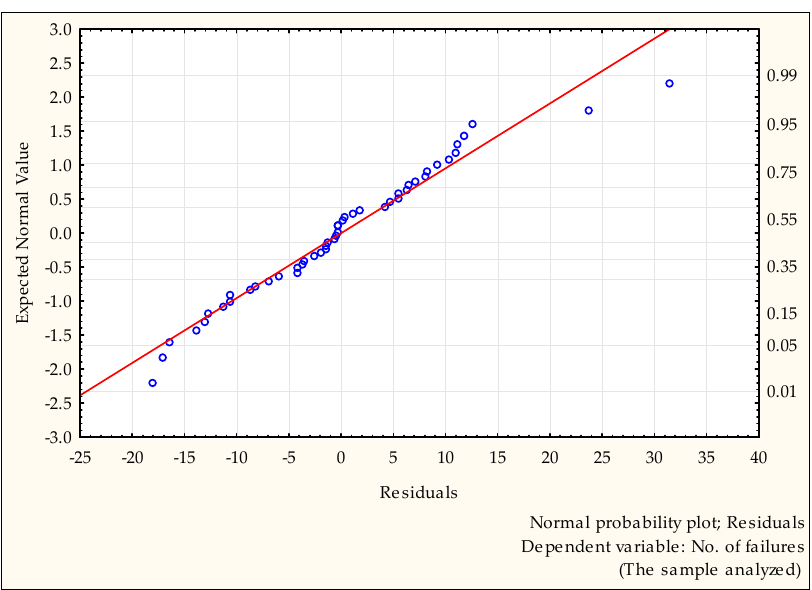
Figure 4. Normal probability plot.